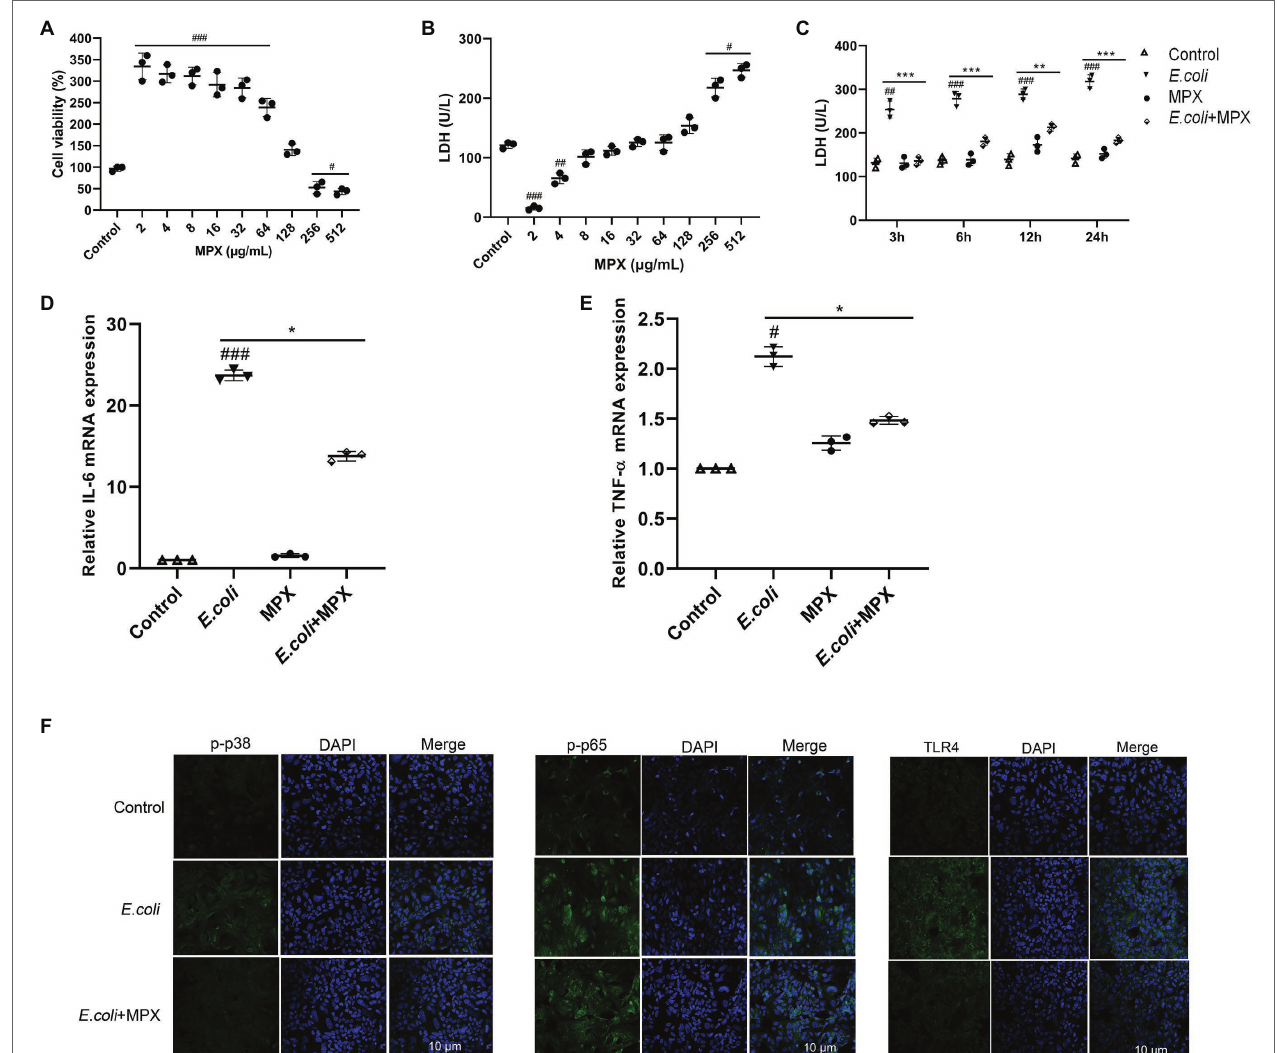
FIGURE 1 | MPX does not induce cytotoxicity and alleviates inflammation in IPEC-J2 cells. (A) Cell viability was measured using the CCK-8 assay, IPEC-J2 cells were cultured with different concentrations (2-512 µg/mL) of MPX for 24 h. (B) The release of LDH from IPEC-J2 cells after treatment with different concentrations (2-512 µg/mL) of MPX for 24 h. (C) MPX decreased the E. coli -induced release of LDH from IPEC-J2 cells (MOI = 10) at different times. (D,E) The mRNA expression of IL-6 and TNF- α after MPX treatment. (F) The expression of p-p38, p-p65 and TLR4 in IPEC-J2 cells assessed by confocal laser microscopy. Error bars represent mean ± SEM, n = 3. Statistical significance was defined as follows: # P < 0.05; ## P < 0.01; ### P < 0.001 E. coli vs control; * P < 0.05; ** P < 0.01; *** P < 0.001 MPX treatment vs E. coli